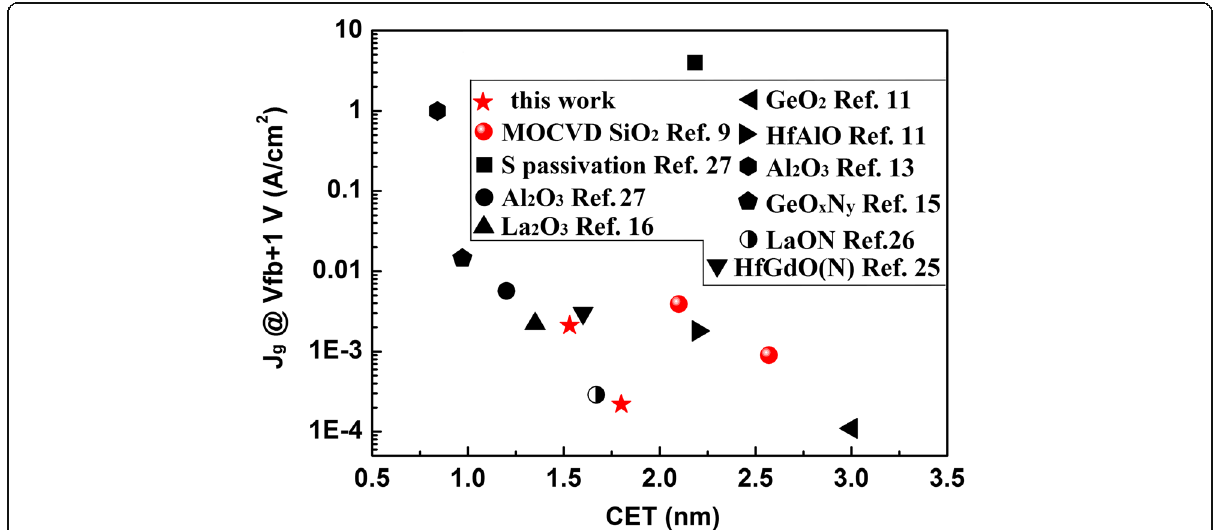
Fig. 4 Leakage current density (Jg)-CET relationship for Ge-based MOS capacitors with different interfacial control layer